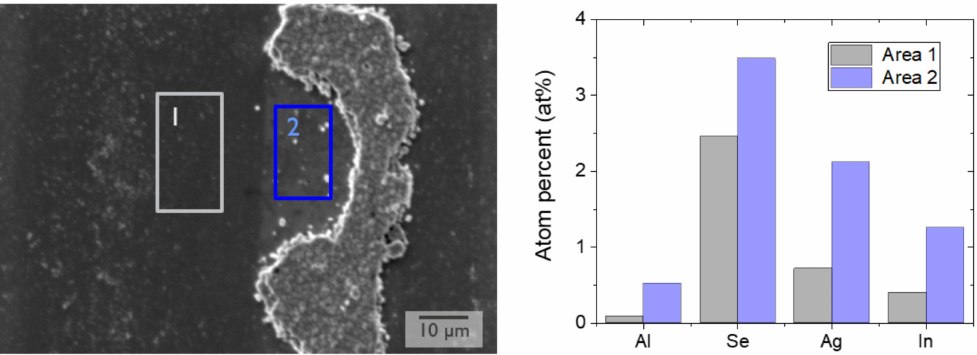
Figure 7. ( Left ) SEM micrograph with the areas where EDS was measured. 1: ‘darker’ area 2: ‘lighter’ area. ( Right ) the atomic percentages of Ag, Al, Se and In of the areas 1 and